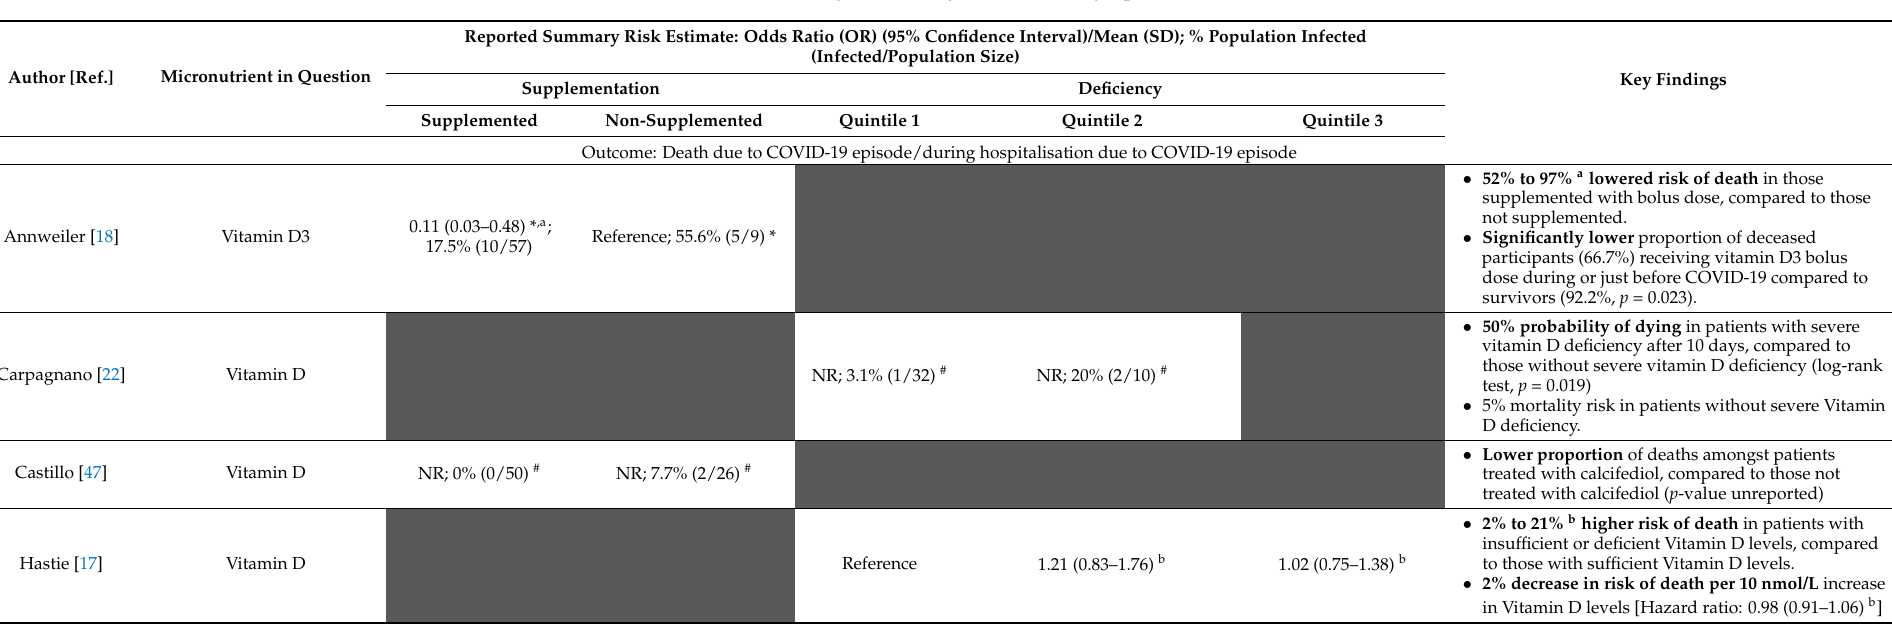
Table 4. COVID-19 Severity defined by without study-specific